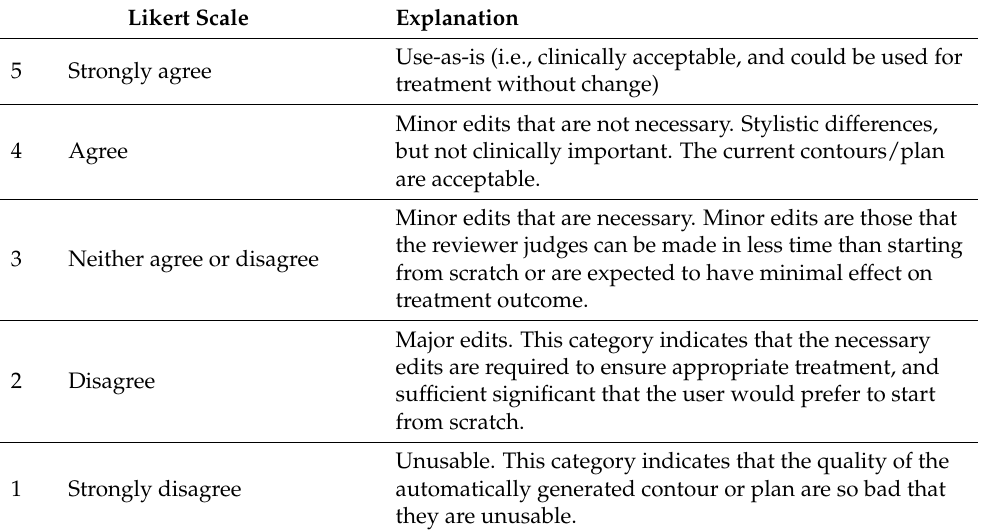
Table 1. Five-point Likert scale used to validate an autosegmentation model deployed at MD Anderson Cancer